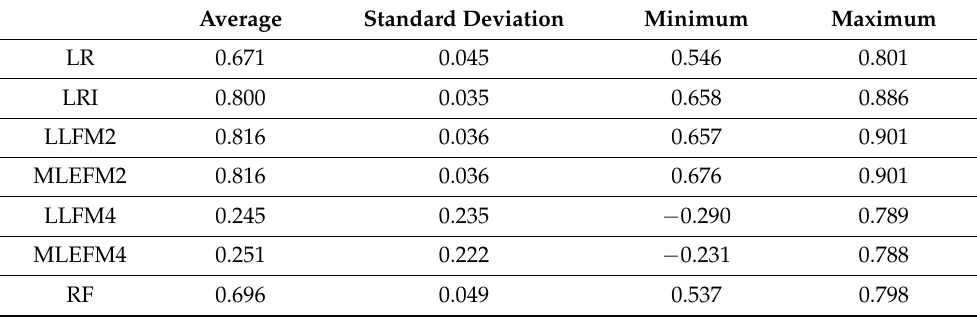
Table 10. Predicted Ginis for the validation set obtained over 200 simulation